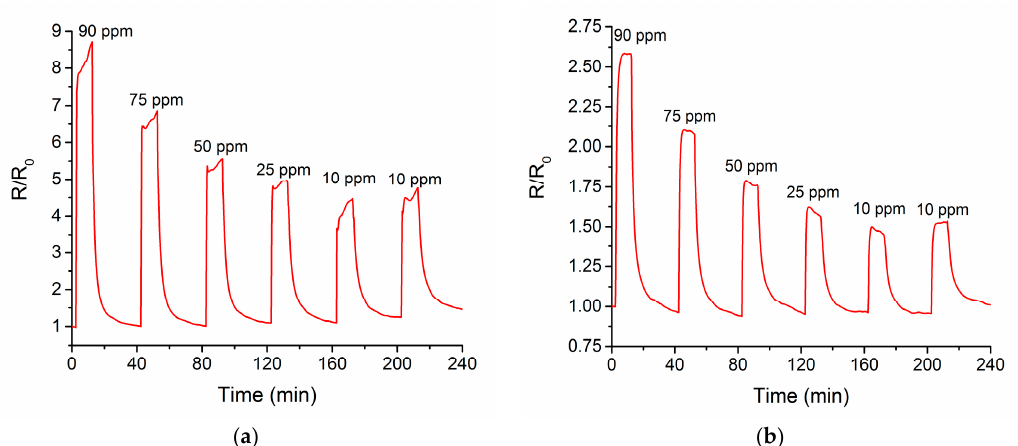
Figure 4. ( a ) Real time response of chemoresistive sensor based on ( a ) ZIF-8 and ZIF-67 combination ( b ) ZIF-67 for different concentrations of